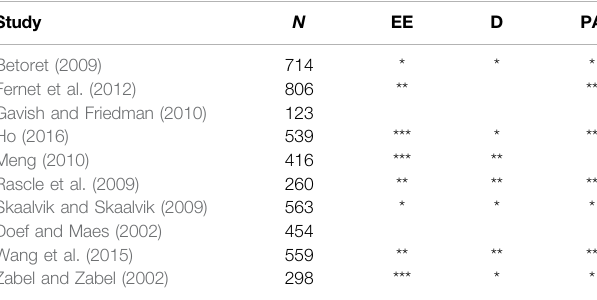
TABLE 6 | Relationships with school principals and burnout.